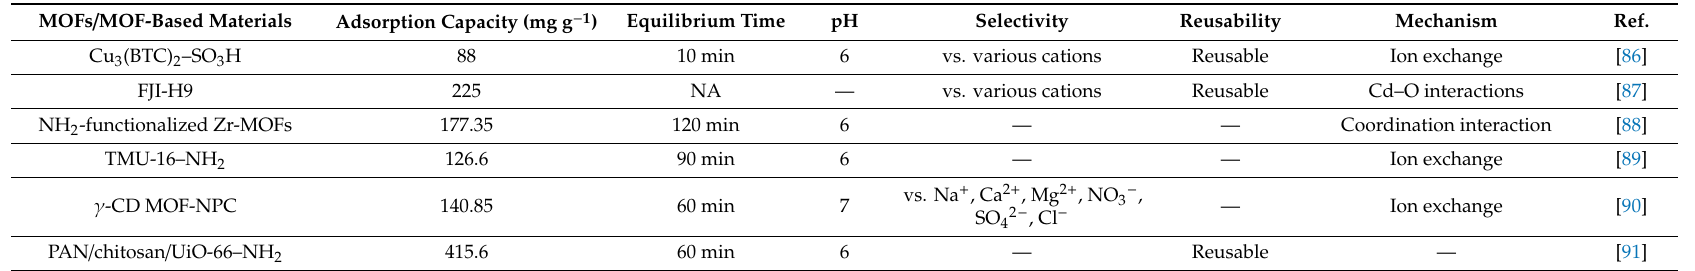
Table 5. Cadmium adsorption data for the reported MOFs and MOF-based